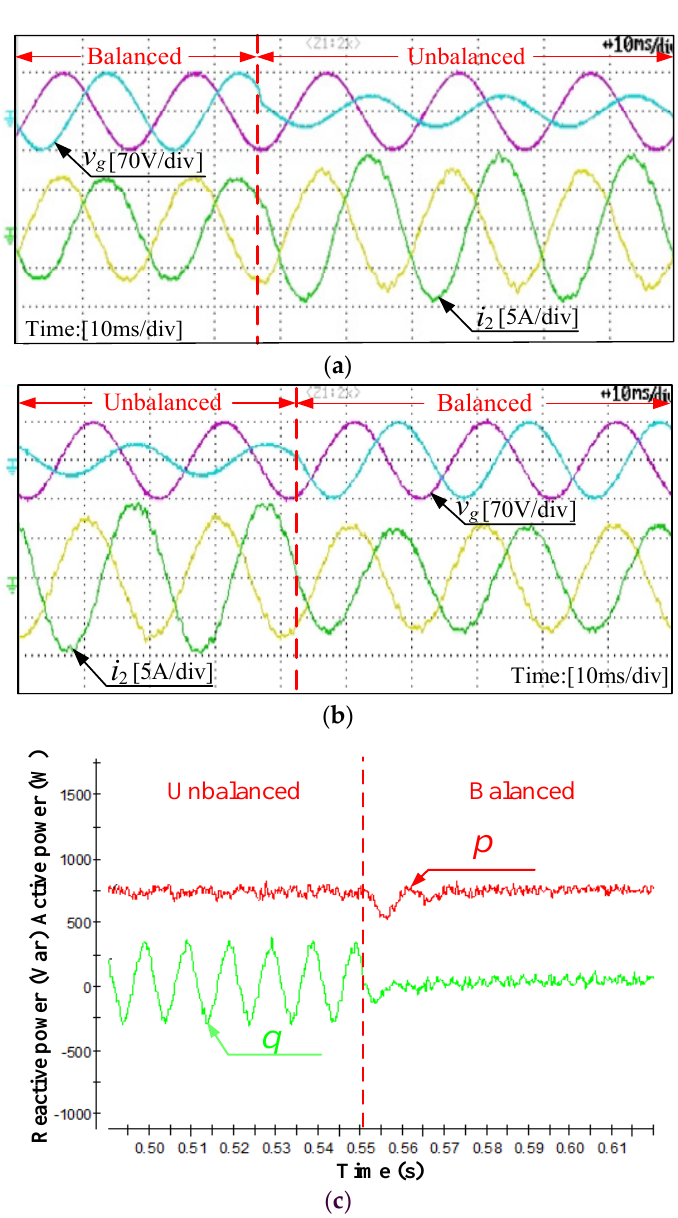
Figure 13. Experimental results of ( a ) grid-injected current when grid voltage varies from balanced to unbalanced, ( b ) grid-injected current when grid voltage varies from unbalanced to balanced, and ( c ) active and reactive power when grid voltage varies from unbalanced to balanced in case 1.